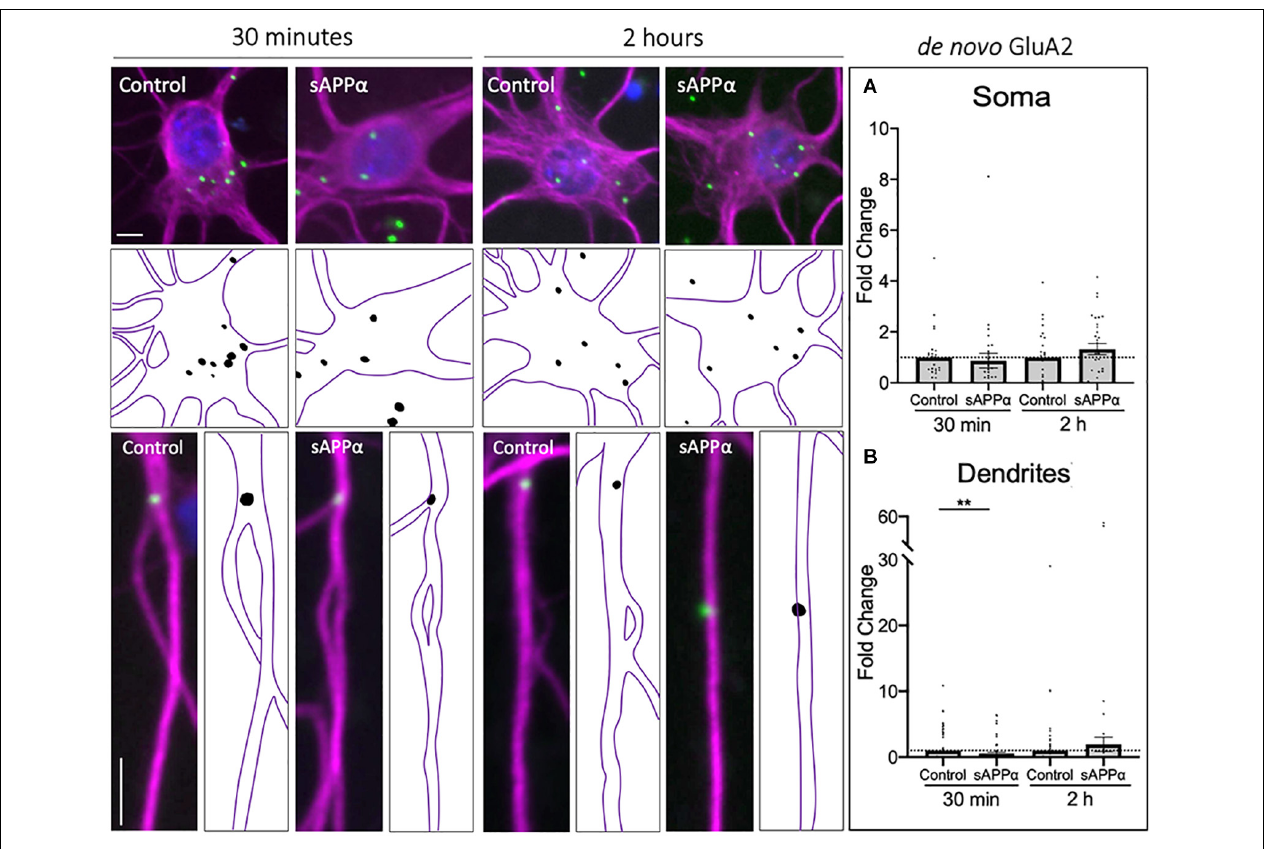
FIGURE 2 | Rapid decrease in de novo cell-surface GluA2 following treatment. Representative images showing cell-surface de novo GluA2 levels in the soma (top panels) and dendrites (lower panels) from 30 min (left) and 2 h (right) controls and sAPP α treated conditions. (A) Average data showing 1 nM sAPP α does not affect somatic ( n = 25–31 cells) de novo GluA2. (B) Average data showing 1 nM sAPP α (30 min) significantly decreases dendritic de novo GluA2 ( n = 71–76). All data are expressed relative to control, as mean ± SEM from 3 experiments. Outliers were removed from each experiment prior to amalgamation using Grubb’s tests, and normality was detected by D’Agostino and Pearson omnibus normality tests. Significance was assessed by student’s t -test, ** p ≤ 0.01. Representative images show neuronal soma (upper panels) and dendrites (lower panels; MAP2; (cid:4) ; GluA1, (cid:4) ; DAPI; (cid:4) ). Scale bars = 10 µ